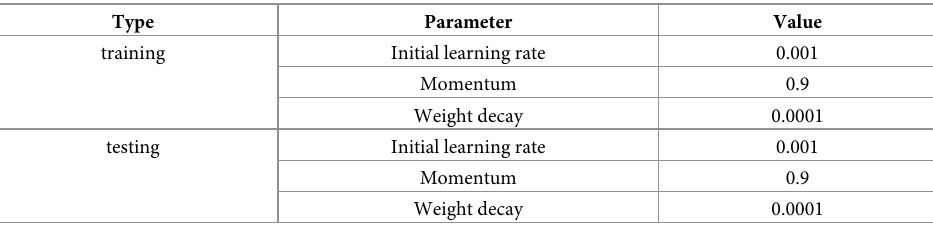
Table 3. Network parameter